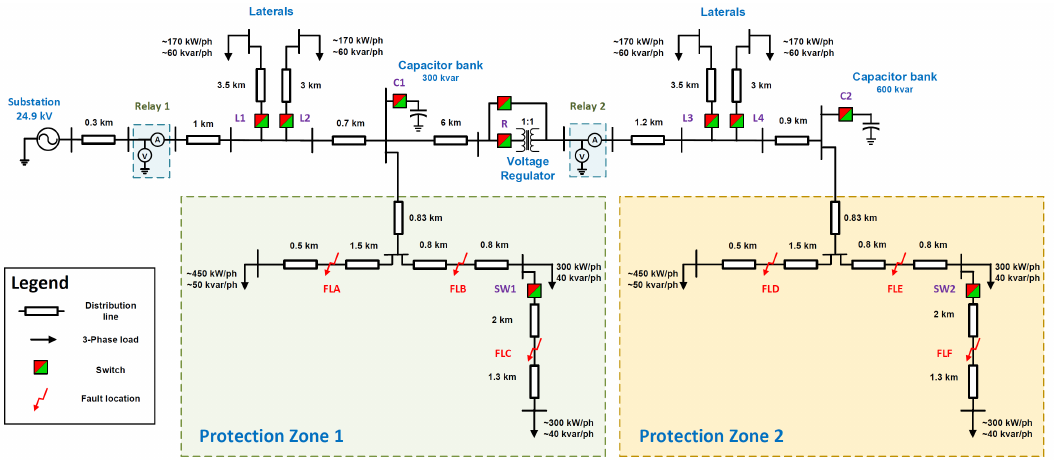
Figure 3. Proposed distribution